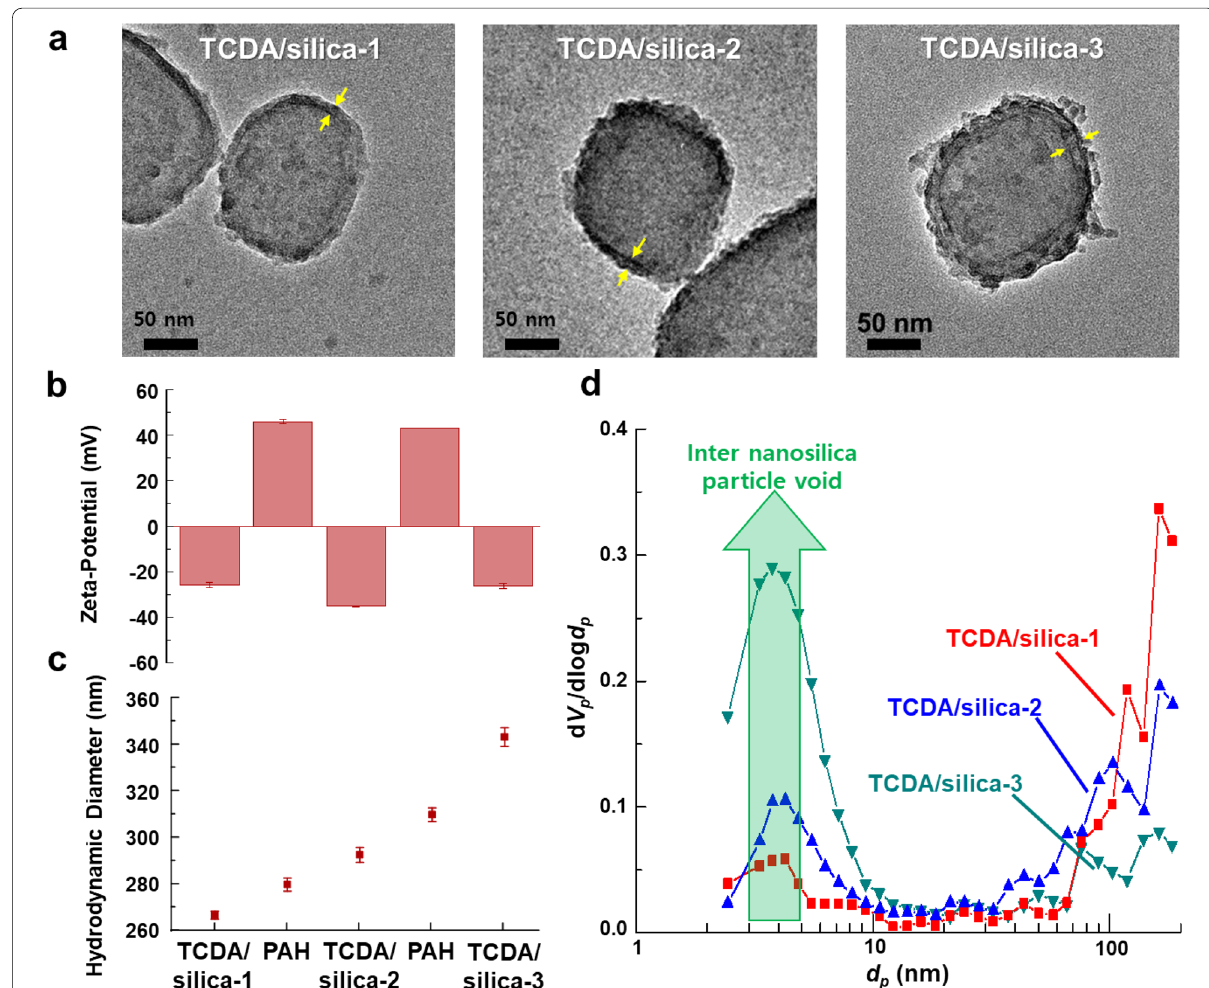
Fig. 5 a TEM images, b Surface charge and c HDD of monomeric TCDA vesicles with repeated silica armor membranes. d Brunauer–Emmett–Teller (BET) analysis results of the silica armor membranes on monomeric TCDA vesicles. The n value of PCDA/silica-n indicates the number of silica armor